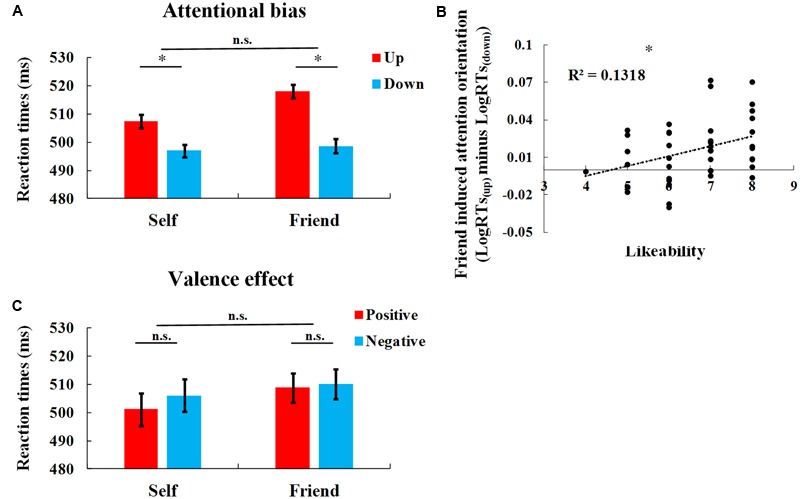
Results of study 1. (A) RTs to targets in different conditions. The RTs are reported in raw millisecond values to facilitate comprehension. Error bars represent within-subject standard error of the mean. (B) Correlation between downward attention orientation effect (lgRTup-lgRTdown) after friend-reflection and the likeability of the friend. (C) RTs to targets after positive and negation reflection. The RTs are reported in raw millisecond values to facilitate comprehension. Error bars represent within-subject standard error of the mean. ∗p < 0.05.